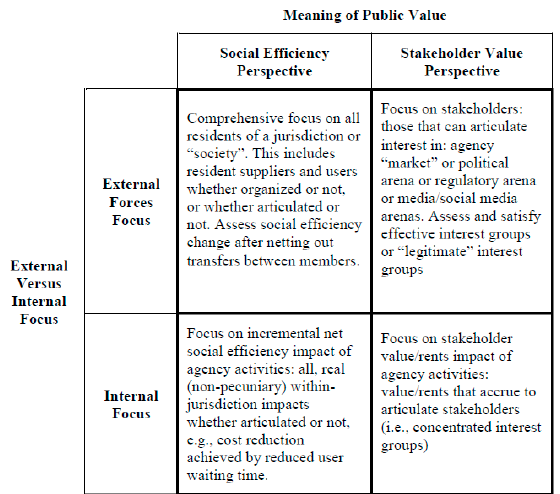
Figure 2. The Difference Between, and Consequences of, Two Distinct Meanings of Public Value: Social Efficiency Perspective versus Stakeholder Perspective.